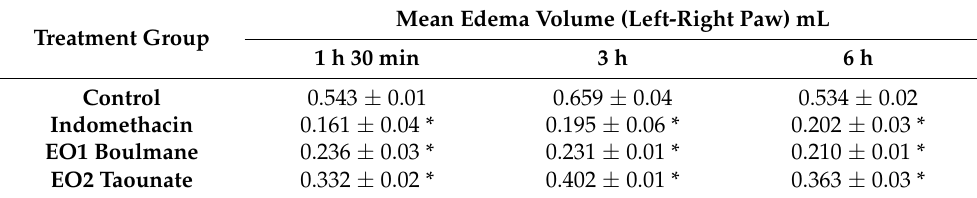
Table 4. Effect of O. compactum essential oils on carrageenan-induced rat paw. Treatment